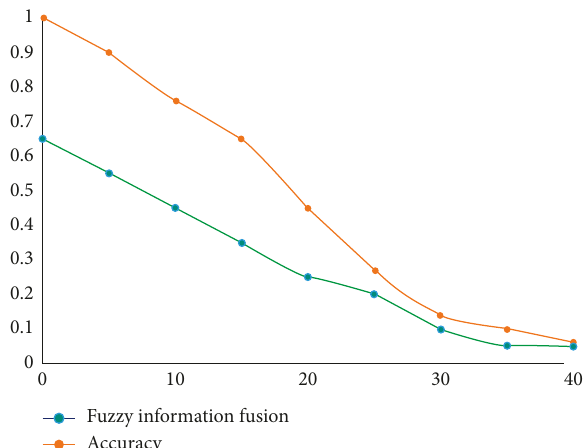
Figure 3: The smoothed curves of low texture with